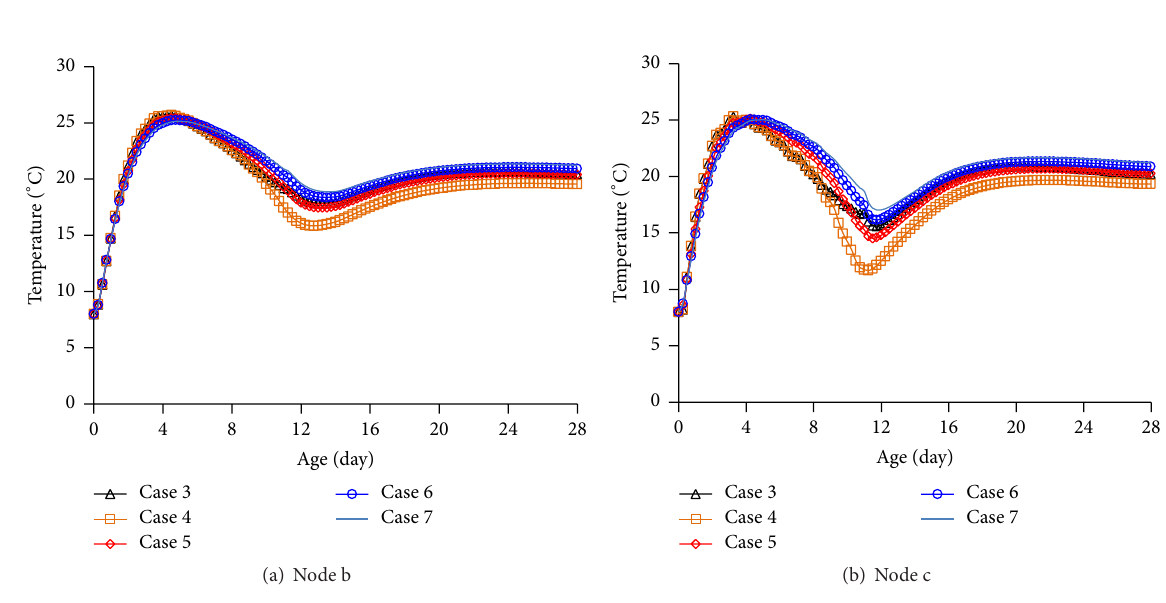
Figure 16: The temperature prediction results of typical nodes.